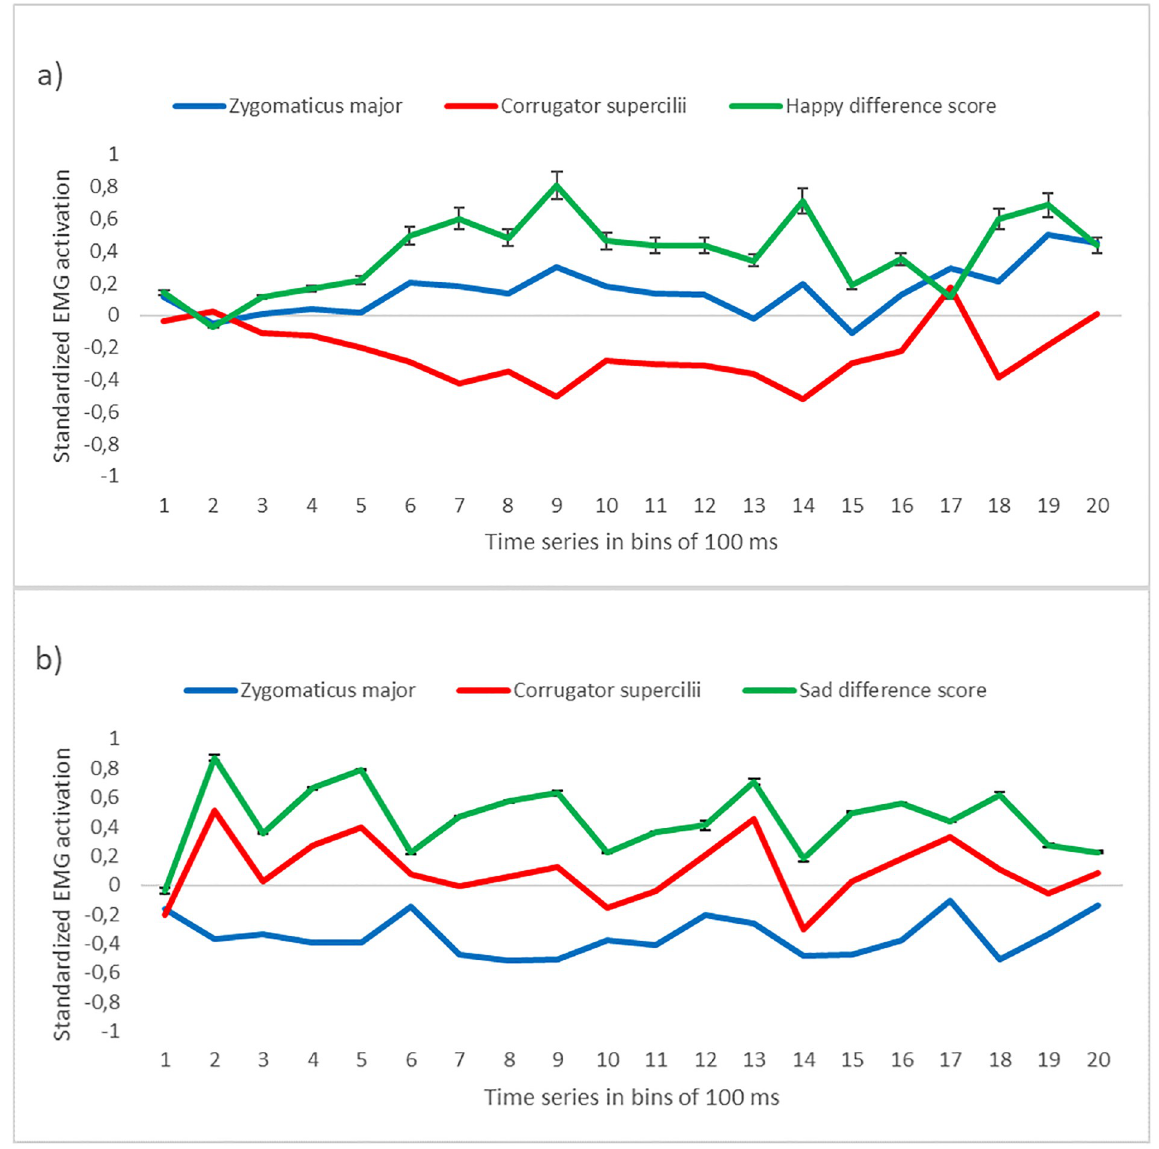
Fig 2. EMG time course activation plots. Time course of standardized EMG activation of the corrugator supercilii (red) and zygomaticus major (blue) muscles, in response to happy (a) and sad (b) stimuli in bins of 100 ms from stimulus onset (0 ms) to stimulus offset (2000 ms). The green line represents the difference score between the two muscles for happy (a) and sad (b) stimuli in which each bin represents the mean (with the standard error) amplitude over 100 ms time.